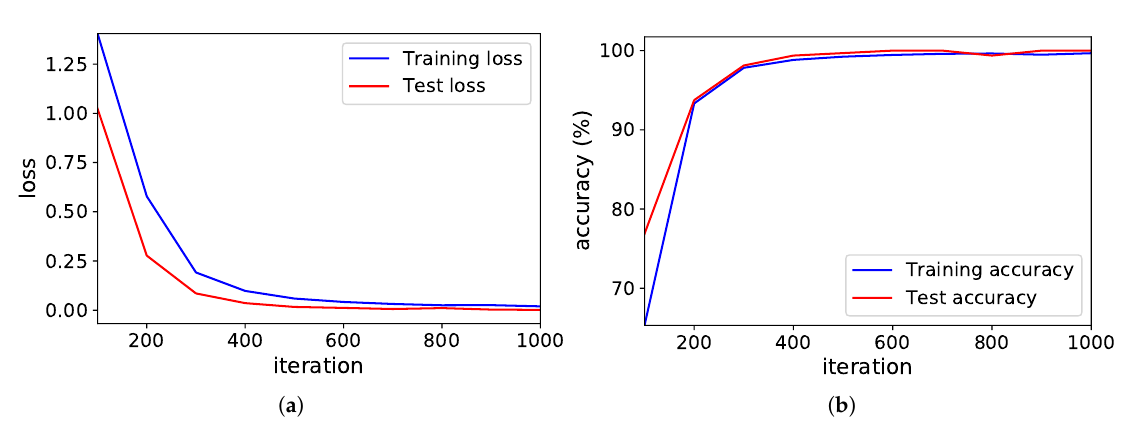
Figure 4. The results of the dependence type classification. ( a ) Loss, ( b ) accuracy.